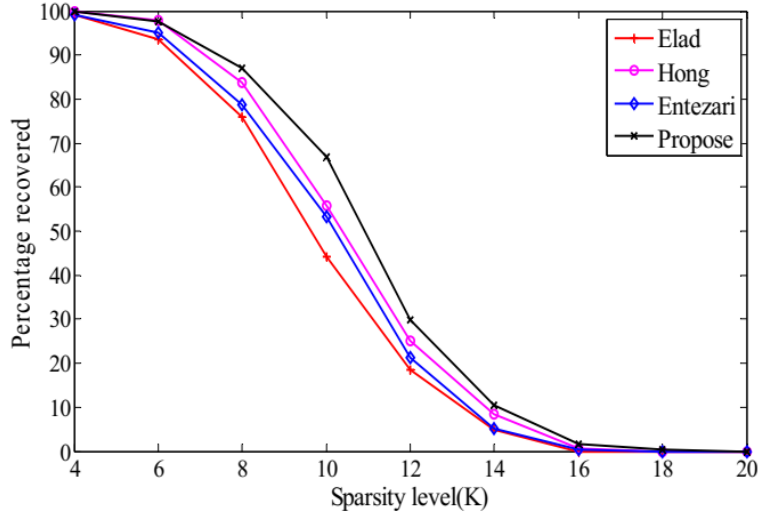
Figure 5. The change tendency of P suc with K while M = 28 in the noiseless